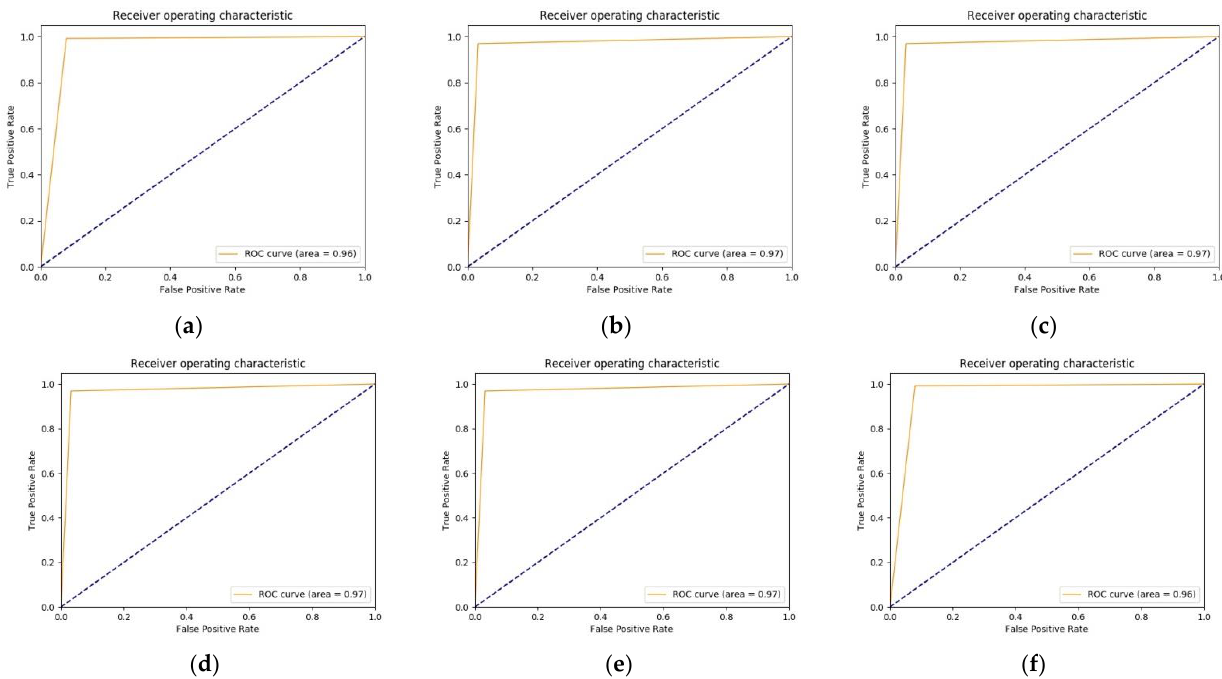
Figure 6. ROC curves for different considered pretrained models: ( a ) VGG16; ( b ) ResNet50; ( c ) GoogLeNet; ( d ) Inception-v3; ( e ) Inception-v4; and ( f ) IR-v2.